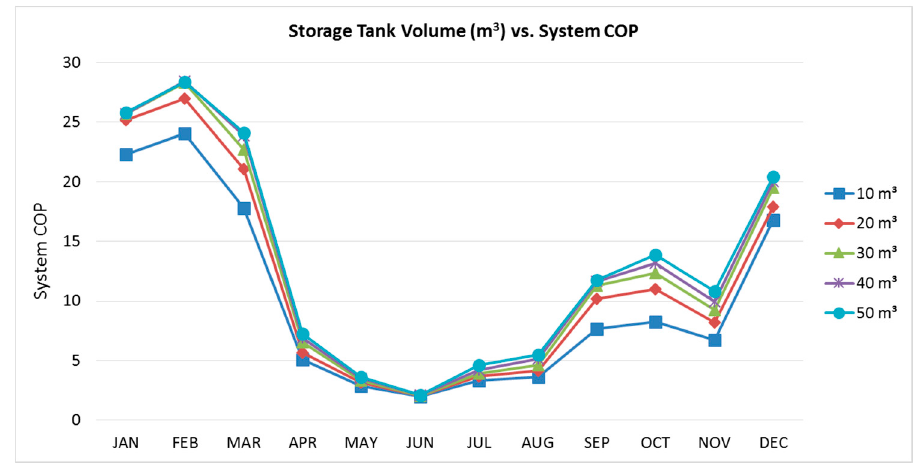
Figure 7. The impact of storage tank volume on system COP.